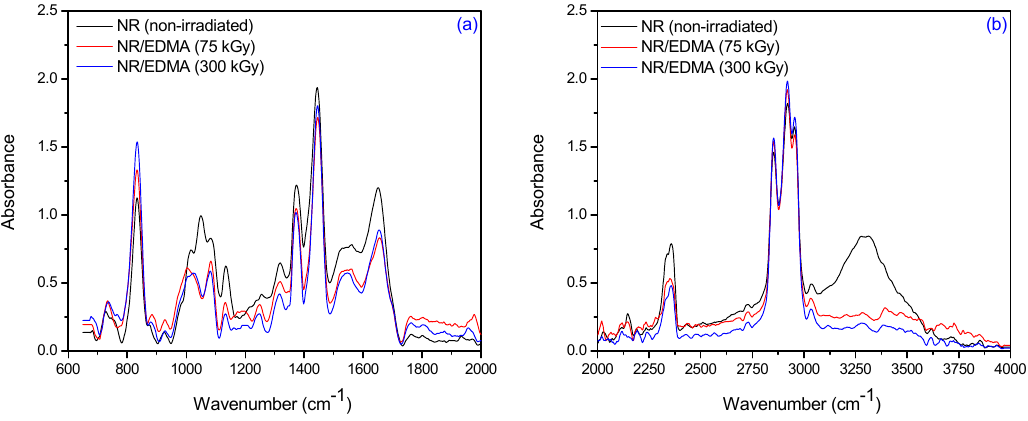
Figure 9. FTIR spectra in the range of ( a ) 2000 cm − 1 –600 cm − 1 and ( b ) 4000 cm − 1 –2000 cm − 1 for NR/EDMA irradiated at 75 kGy and 300 kGy.